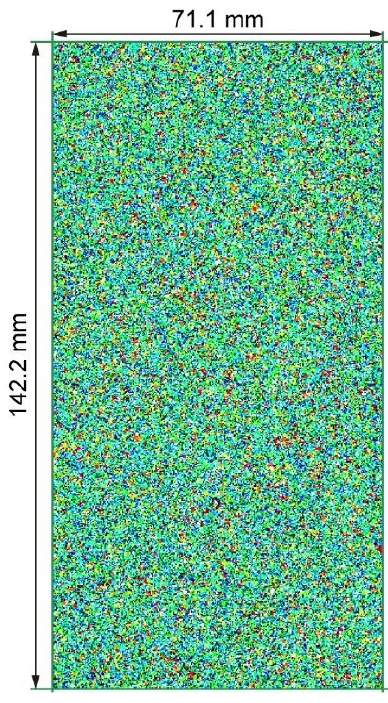
Figure 3. Schematic of the constitutive model of particle-particle contact.